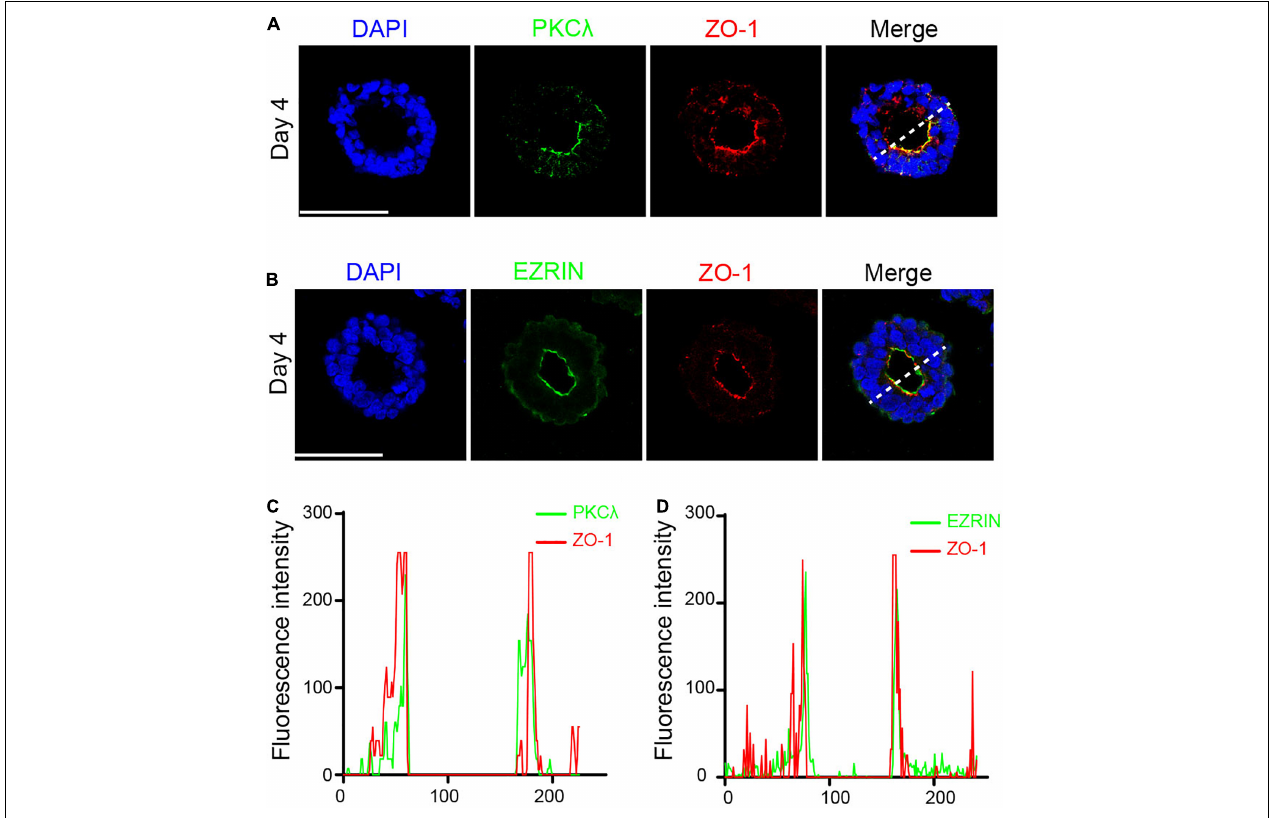
FIGURE 4 | Polarized protein co-localized with ZO-1 at the apical area. (A) PKC λ was enriched at the apical part of epithelial cells. (B) EZRIN was enriched at the apical part of epithelial cells. (C,D) PKC λ and EZRIN co-localized with ZO-1 at the apical area. Scale bars: 50 µ